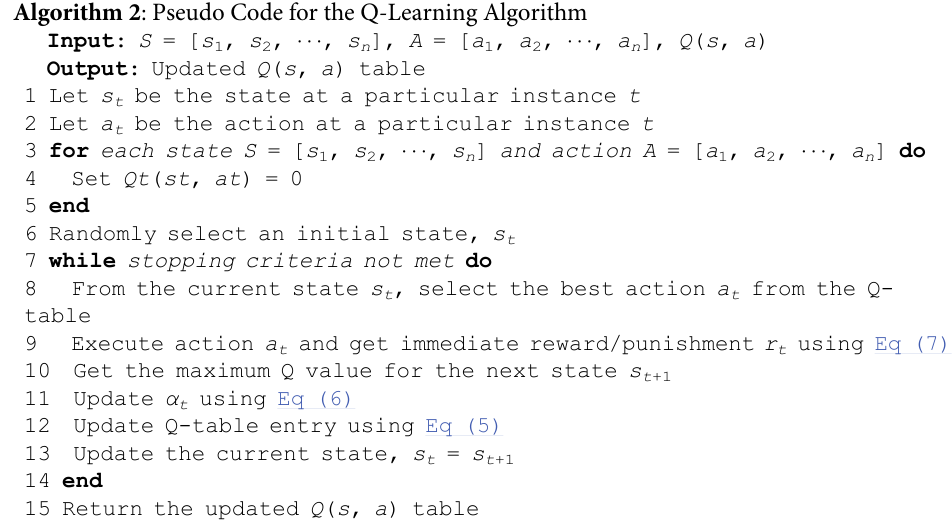
Algorithm 2 : Pseudo Code for the Q-Learning